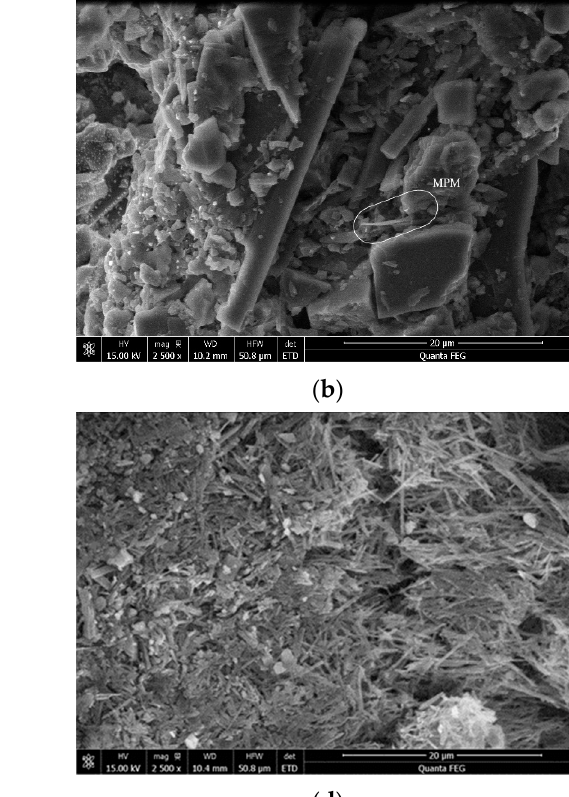
Figure 3. SEM images of the morphologies of photocatalytic putty powder with different PFWC spray amounts: ( a ) pure putty powder; ( b ) PFWC-63/putty powder; ( c ) PFWC-133/putty powder; ( d ) PFWC-439/putty powder.